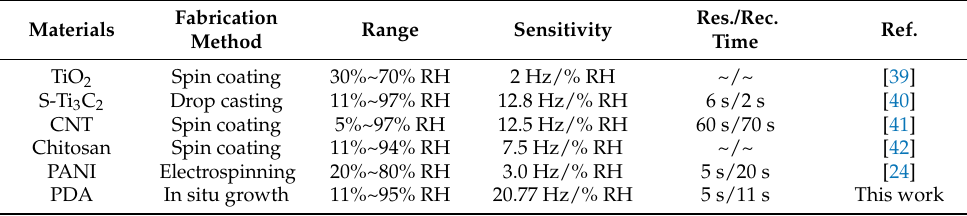
Table 4. Comparison between QCM humidity sensor in this work and reported works.